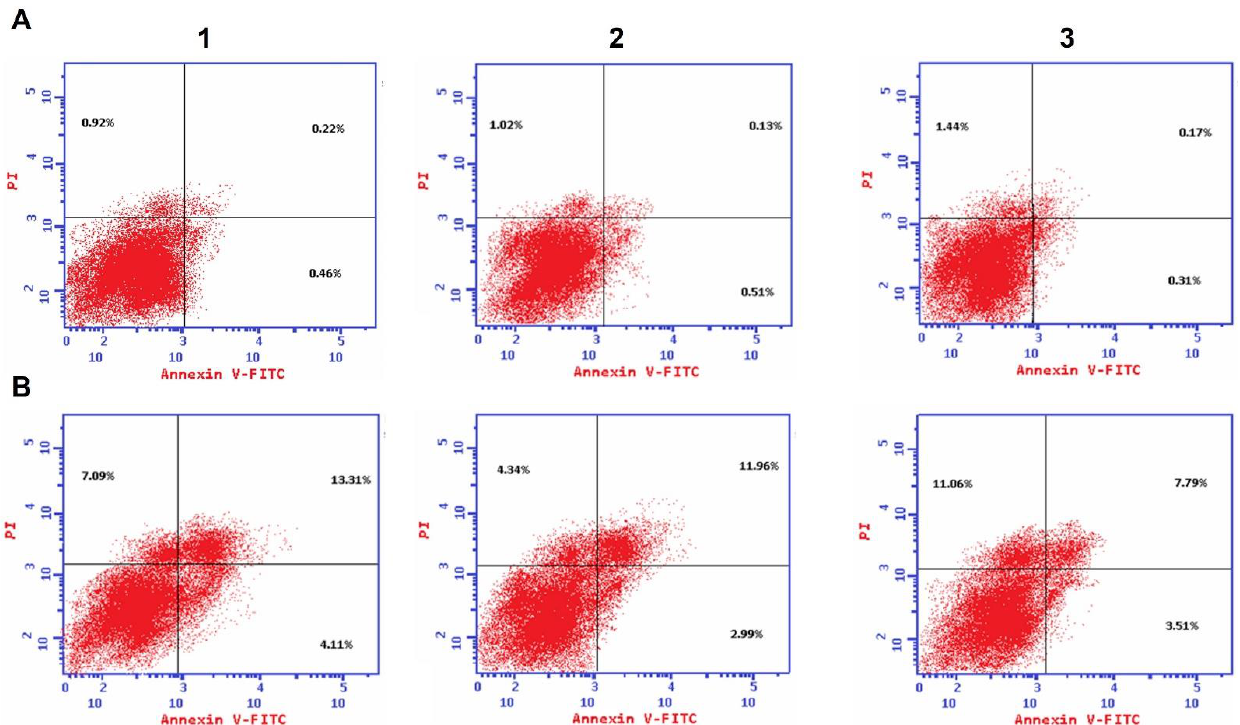
Figure 4. IC50 in ( A ) untreated (1) HCT116, (2) MCF-7, and (3) TT cell lines compared to ( B ) IC50 of C. ternatea extract induces apoptosis in (1) HCT116, (2) MCF-7, and (3).